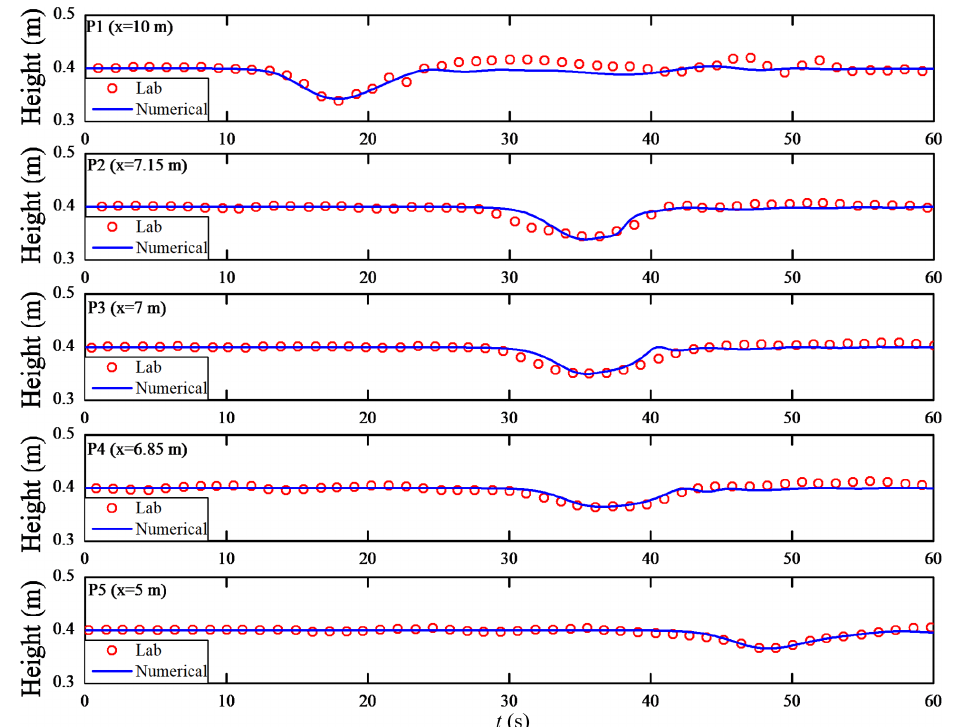
Figure 11. Comparison of the waveform between the experimental results in Hsieh et al. (2015) and numerical simulation results at probes P1–P5.